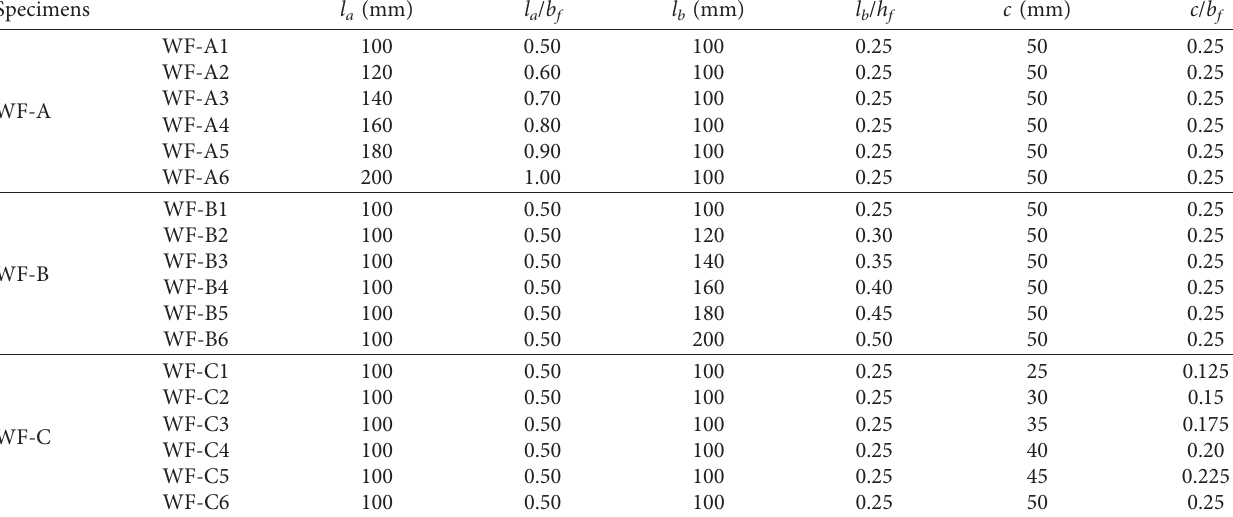
Table 3: Size of